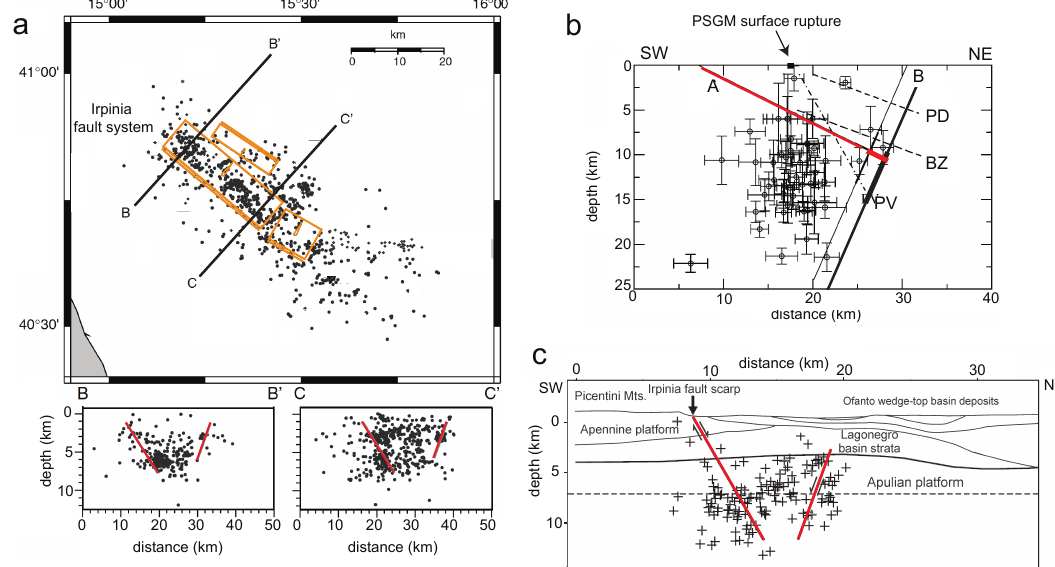
Figure 5. ( a ) Seismicity of the Irpinia region from August 2005 to April 2011 in map view (in orange, seismogenic sources from DISS working group [88]) and in cross-sections, along the profiles reported in the map (the red lines represent the projection of the fault segments activated with the 1980 earthquake) (from De Matteis et al. [4], modified). ( b ) Comparison of models for the 20 s fault, and projection of aftershocks (crosses indicate uncertainty) localized on a vertical N31E cross-section cutting across the PSGM; A and B (e ff ectively slipped area: thick line): Amoruso et al. [90]; BZ: Bernard and Zollo [1]; PD: Pingue and De Natale [91]; PV: Pantosti and Valensise [12] (from Amoruso et al. [90], modified). ( c ) Gravity profile, and the fault segments and aftershocks [92] (crosses indicate uncertainty) of the 1980 earthquake (partly redrawn from Improta et al.